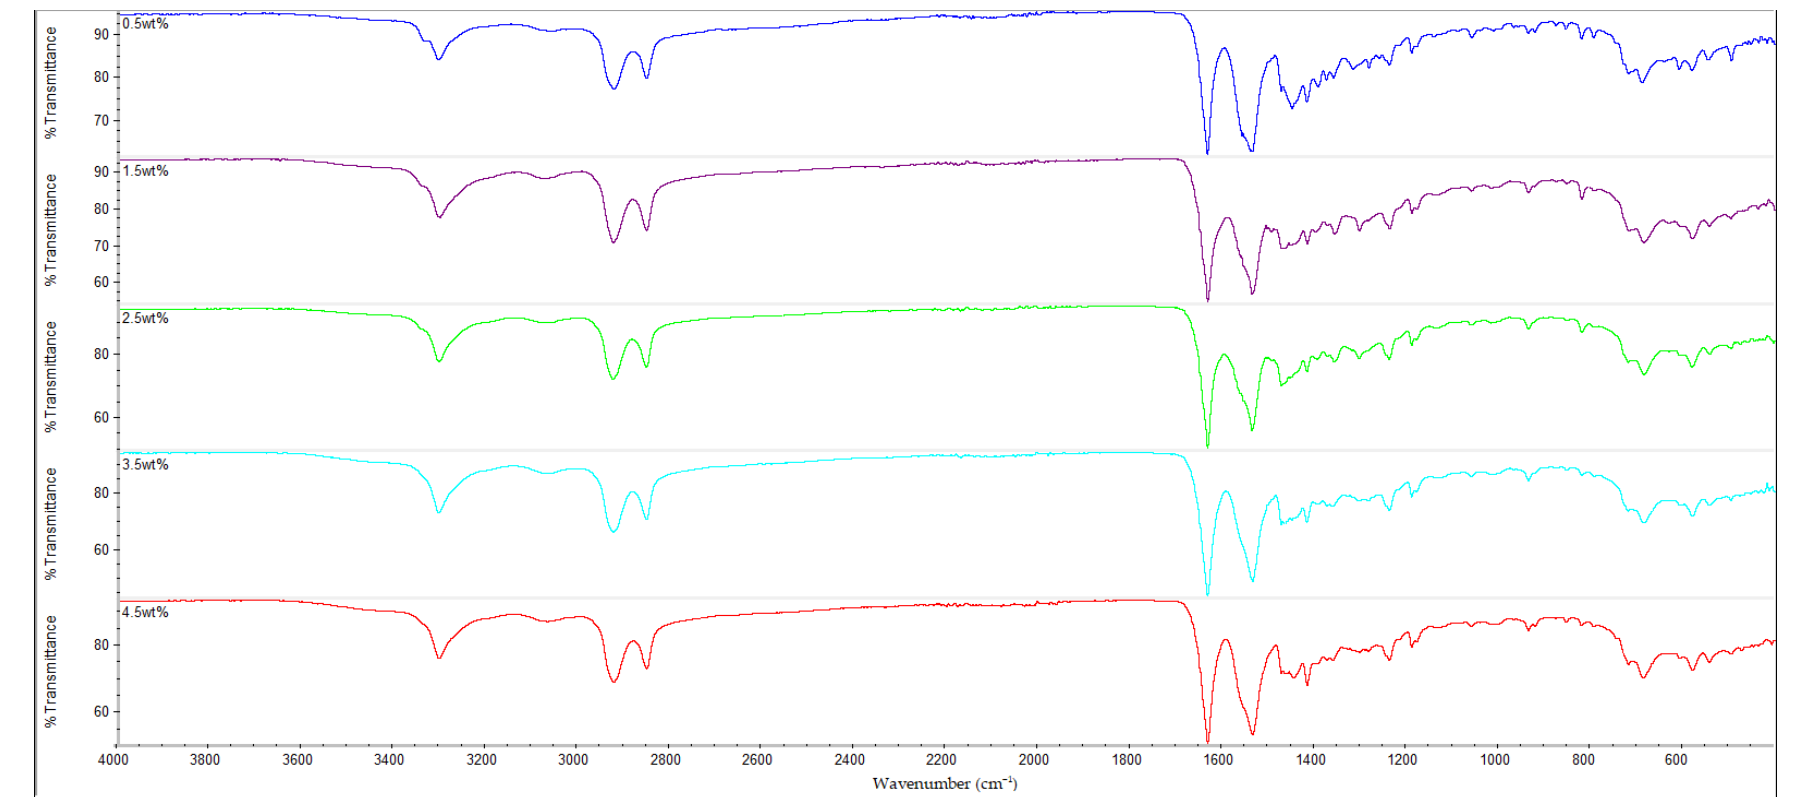
Figure 12. FTIR Spectra for Nylon 610 Nanocomposites with Treated Graphite Flakes at 150 °C and − 0.08 MPa.